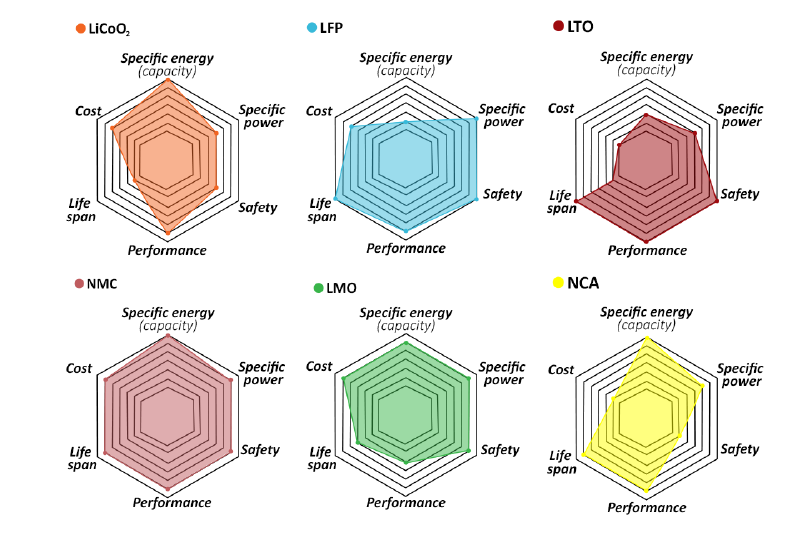
Figure 2. Comparison between different types of cathodes. Adapted from